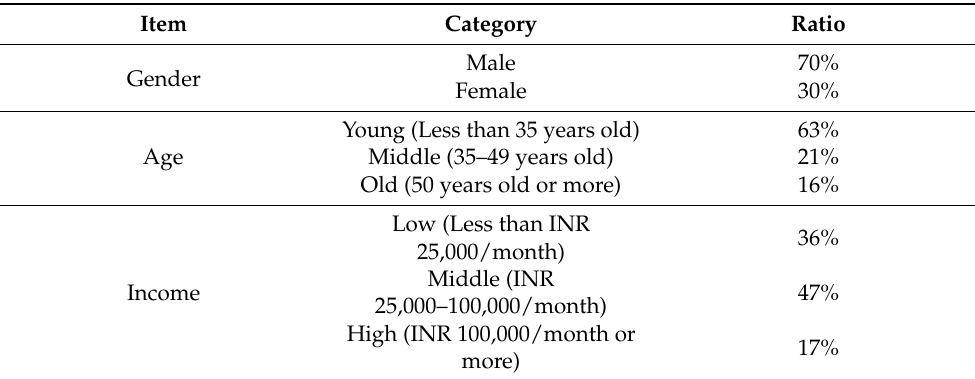
Table 6. Composition ratios of the samples by individuals’ attributes.